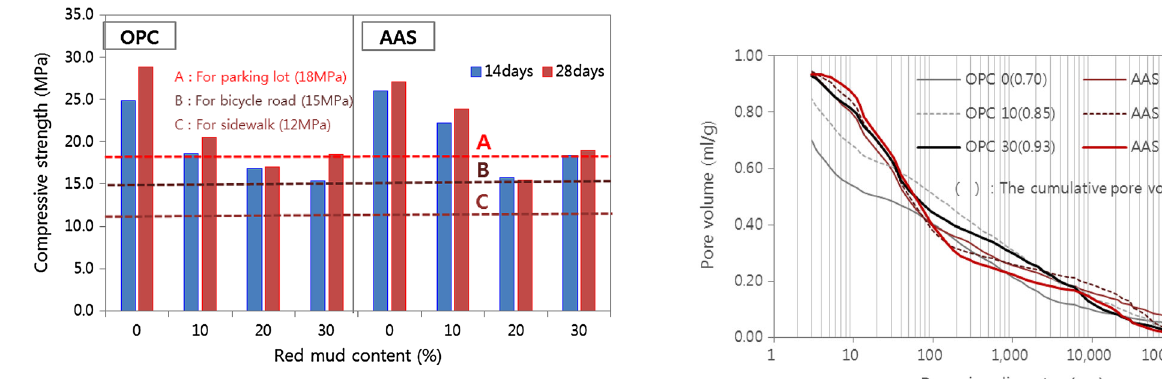
Fig. 7 Optimum moisture content with red mud replacement ratio. Fig. 8 Total pore volume with red mud replacement